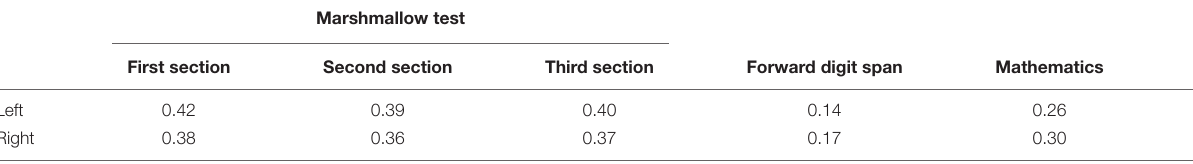
TABLE 1 | Averages for marshmallow test, forward digit span task, math task, and abacus task.